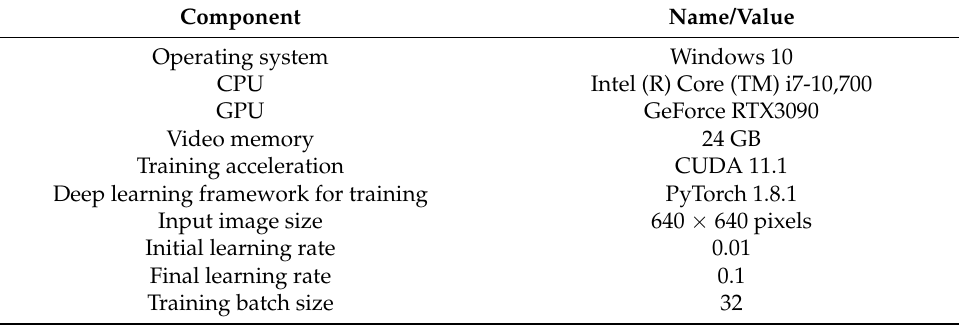
Table 2. Experimental environment’s parameters.